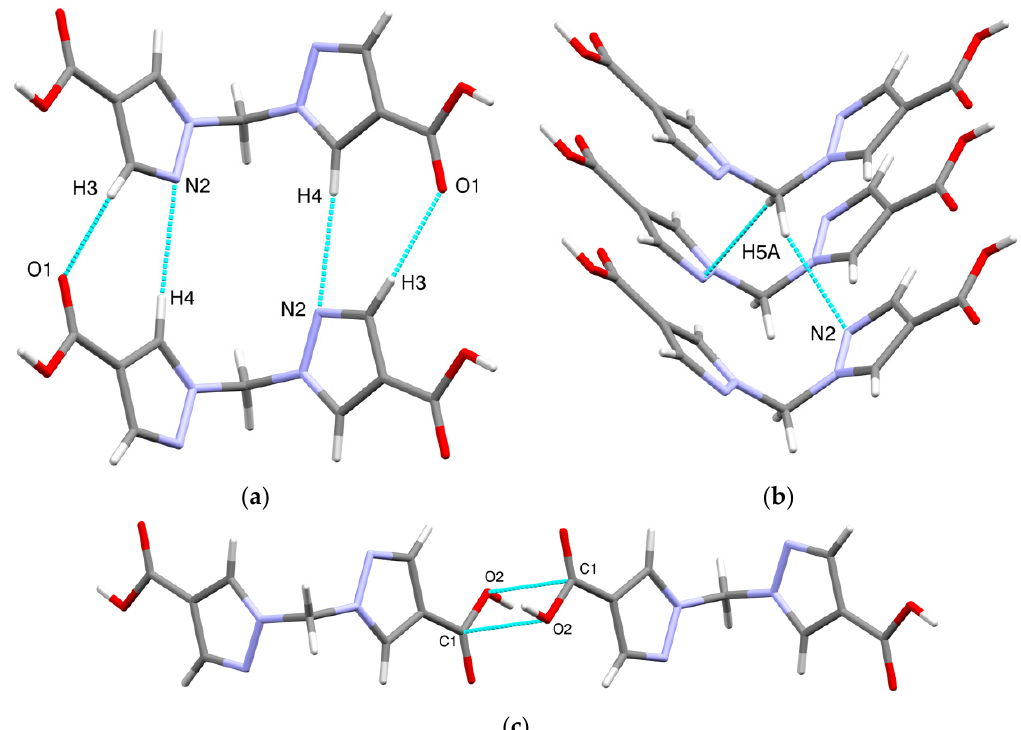
Figure 3. Intermolecular interactions in the crystal structure of H 2 bpmdc: ( a ) short contacts CH···N and CH···O; ( b ) CH– π interactions; ( c ) carbonyl–carbonyl interactions.